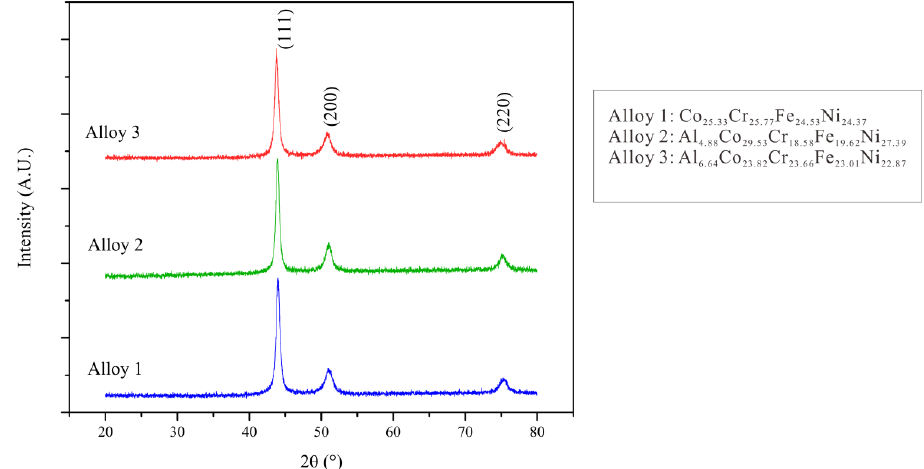
Figure 1. X-ray diffraction patterns of Alloy 1 (Co 25.33 Cr 25.77 Fe 24.53 Ni 24.37 ), Alloy 2 (Al 4.88 Co 29.53 Cr 18.58 Fe 19.62 Ni 27.39 ) and Alloy 3 (Al 6.64 Co 23.82 Cr 23.66 Fe 23.01 Ni 22.87 ), indicating that all of them locate in the single fcc phase